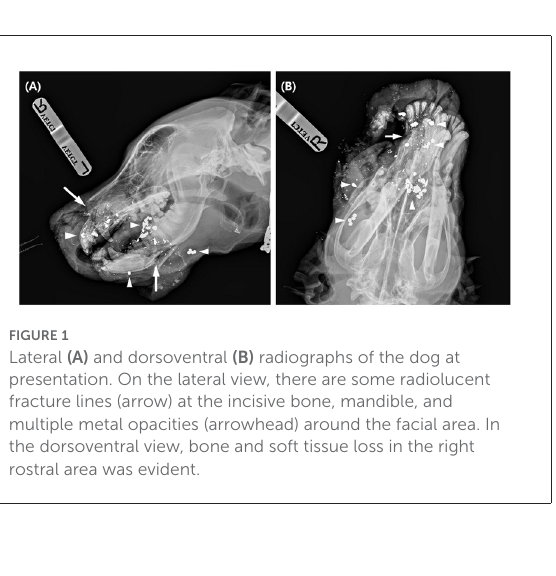
Preoperatively, blood analysis, including